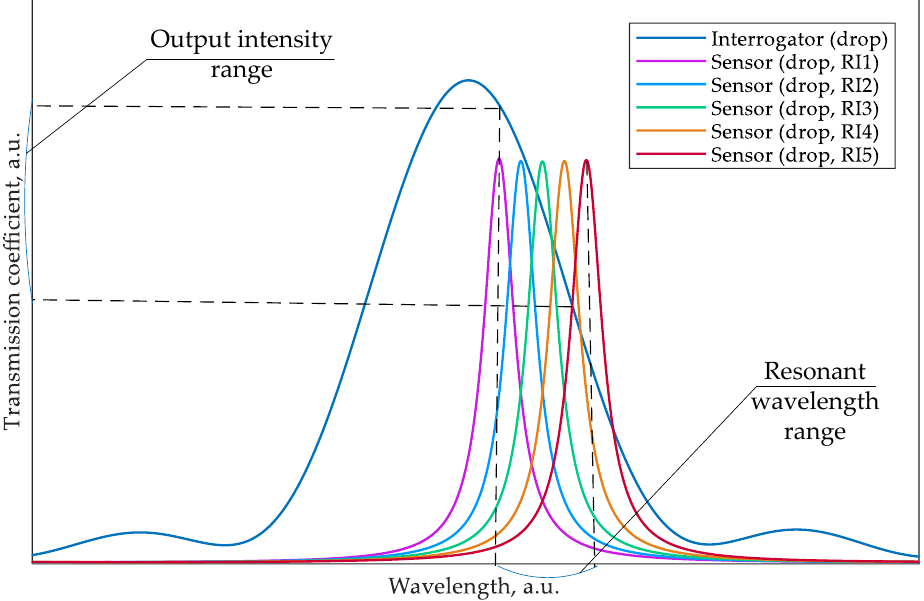
Figure 2. Principle of MRR-based interrogation by intensity.